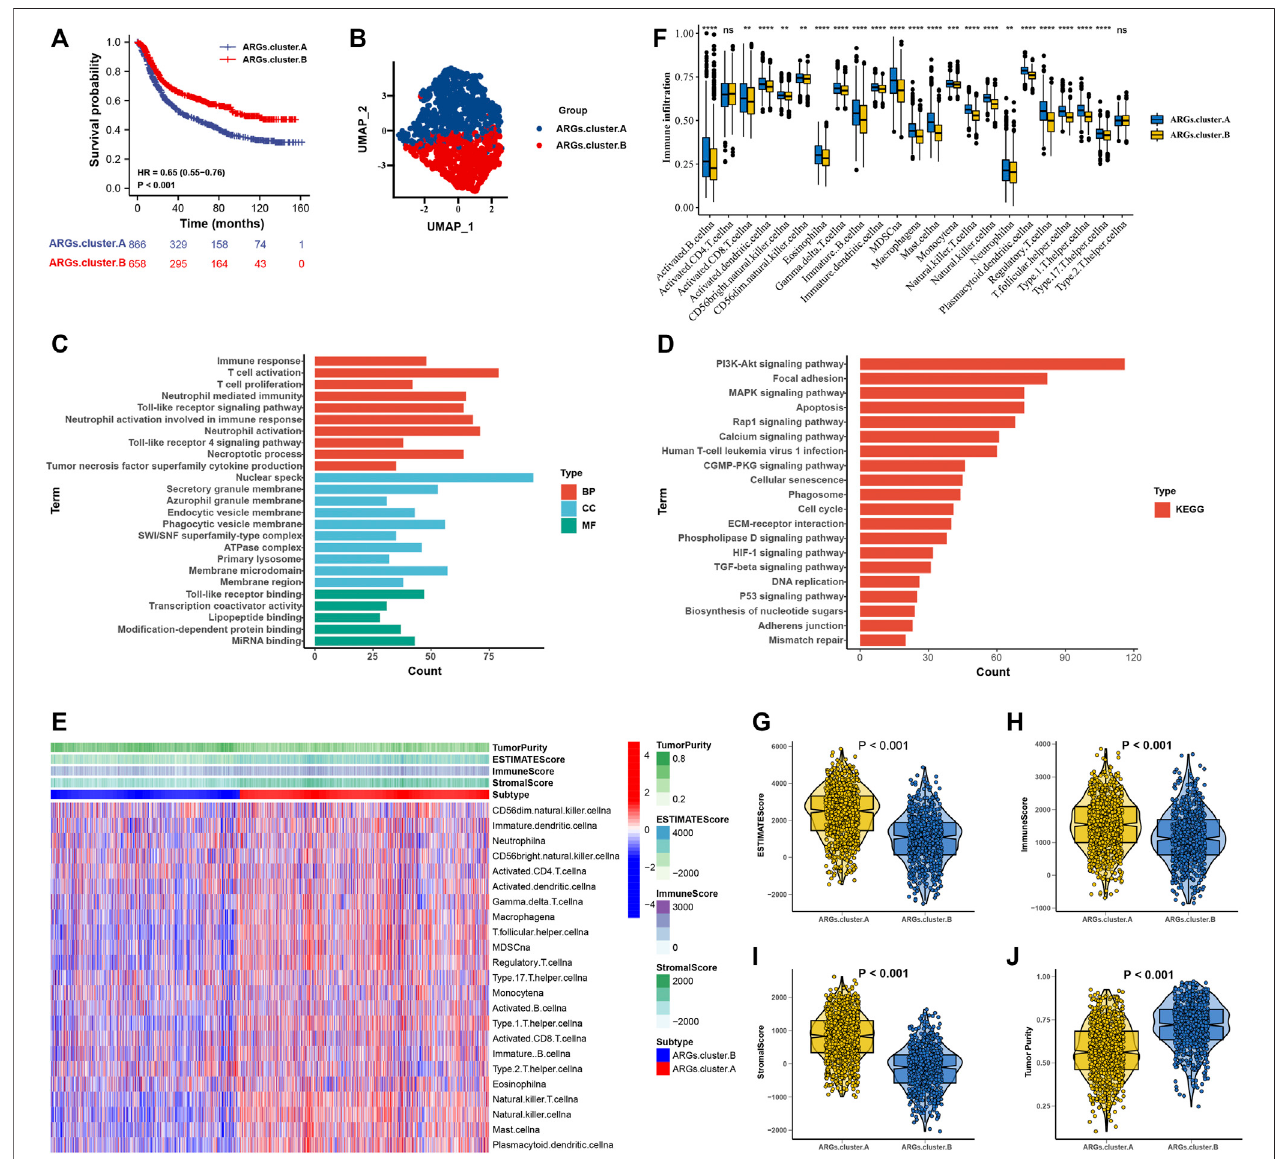
FIGURE 3 | The molecular subtypes categorization of GC base on six ARGs. (A) Kaplan-Meier curve showed a signi fi cant difference between the two ARGs clusters. (B) UMAP analysis for the transcriptome pro fi les of ARGs.cluster.A and ARGs.cluster.B, showing a remarkable difference on transcriptome between different group. (C) GO enrichment analysis (D) KEGG enrichment analysis for the different expression that were correlated with OS genes. (E) The correlation of tumor microenvironment condition and ARGs.cluster. (F) The abundance of each TME in fi ltrating cell in two ARGs clusters. The upper and lower ends of the boxes represented the interquartile range of values. The lines in the boxes represented median value, and black dots showed outliers. (G – J) The ESTIMATE score, stromal score, immune score, and tumor immunity levels in the ARGs.cluster.A and ARGs.cluster.B groups by using ESTIMATE algorithm. (* p < 0.05; ** p < 0.01; *** p < 0.001; **** p <